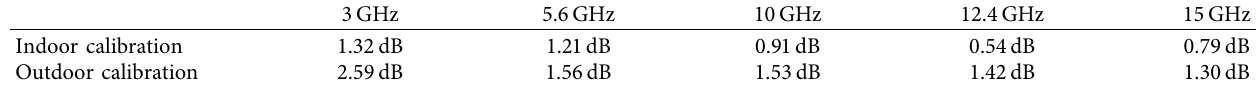
Table 1: RMS errors of the graphite cube measurement results at diferent frequencies.